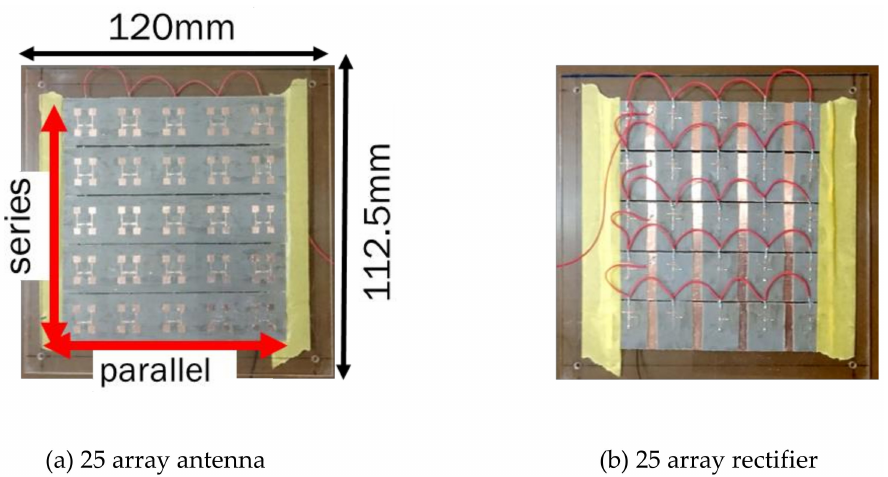
Figure 10. 28 GHz 25 array rectenna: ( a ) 25 array antenna and ( b ) 25 array